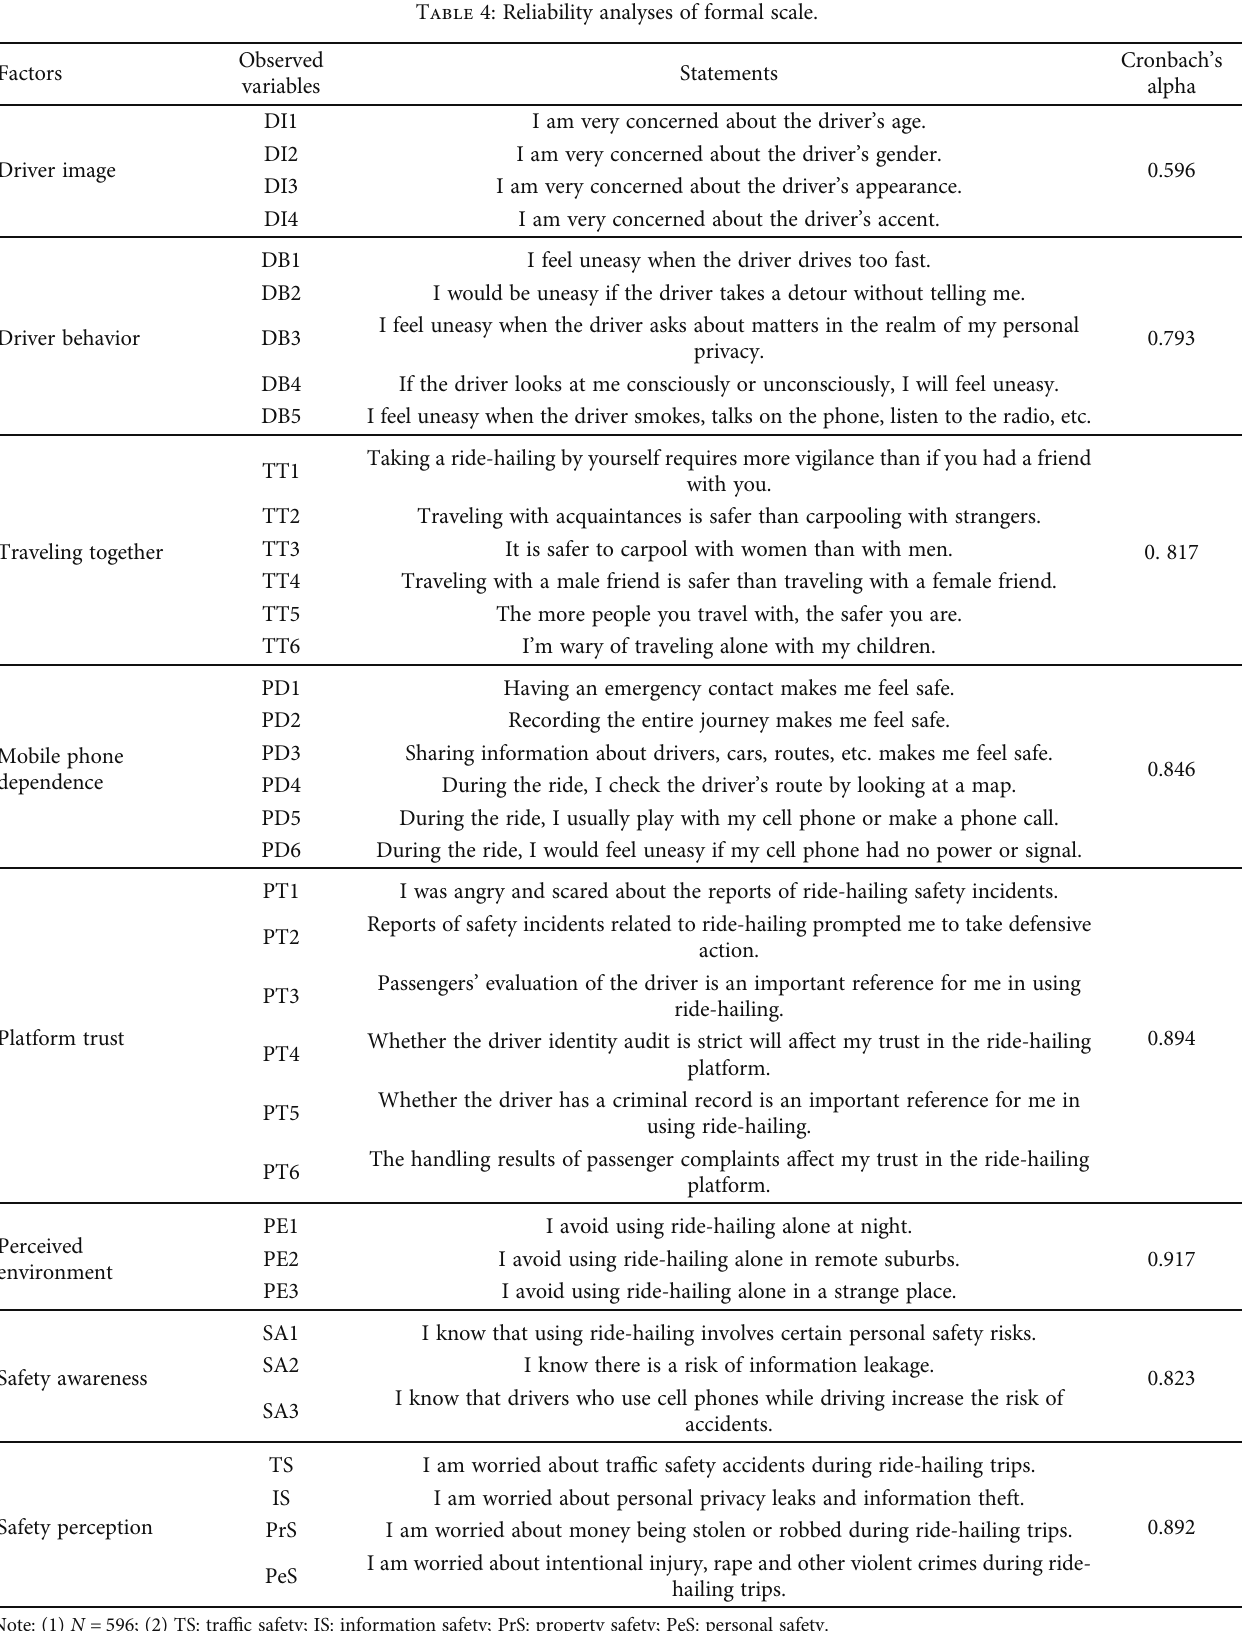
Table 4: Reliability analyses of formal